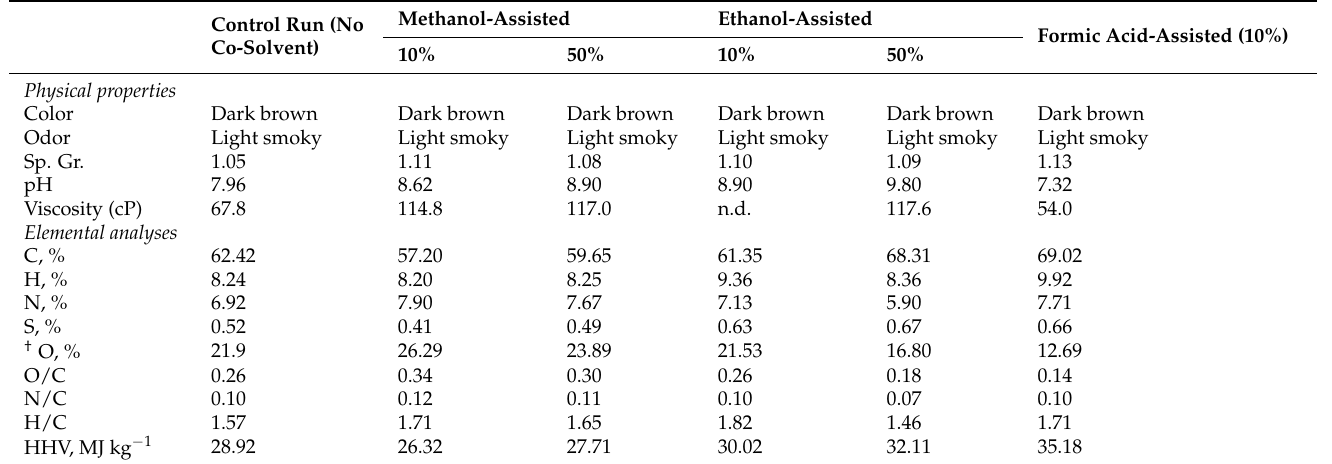
Table 2. Properties of biocrude obtained from co-solvent assisted HTL compared to the control HTL